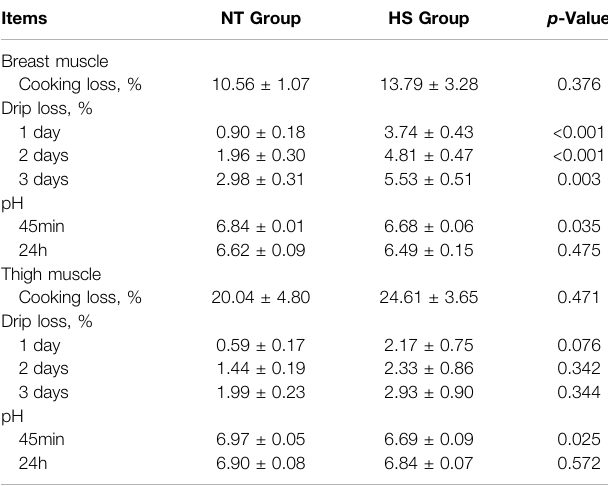
TABLE 3 | Effects of heat stress on meat quality in indigenous broilers. Items